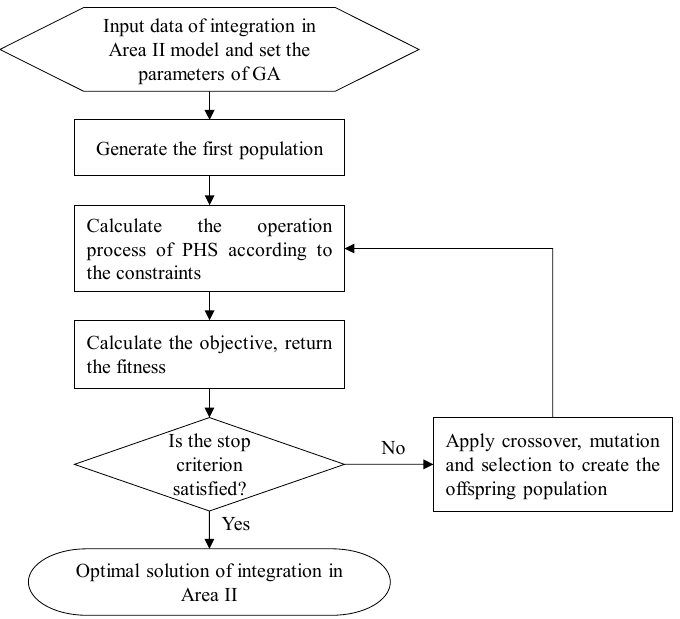
Figure 6. Flow chart of the model decomposition in Area II.